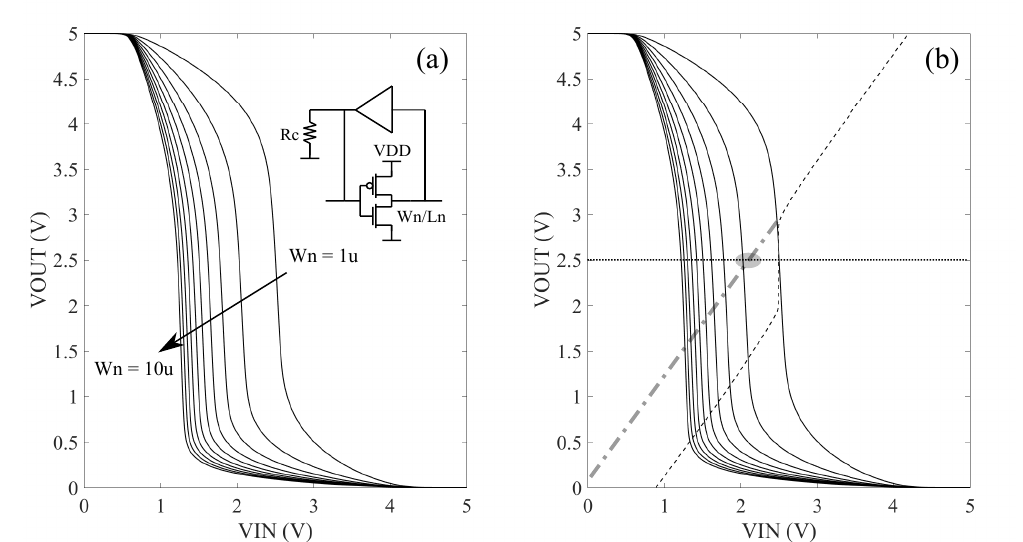
Figure 8. Analysis of the PFGA equilibrium point during a sweep in the width of the NMOS of the inverter. Simulation Results for AMS-350nm model at V DD = 5 V, ( W / L ) p = 2.3 µ m/350 nm, L n = 350 nm ( a ) Effect of the increasing width of the NMOS on the inverter VTC. ( b ) Equilibrium point of PFGA1 for increasing width of the NMOS in the